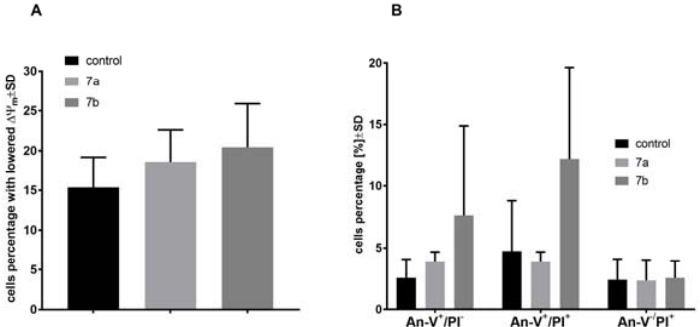
Figure 2. Mitochondrial membrane potential ( ∆Ψ m ) ( A ) and cell death analysis ( B ) of MV4-11 cells after treatment of 1-anisoyl-2-hydroxy- sn -glycero-3-phosphocholine ( 7a ; 30 µ m) and 1-veratroyl-2-hydroxy- sn - glycero-3-phosphocholine ( 7b ; 15 µm).